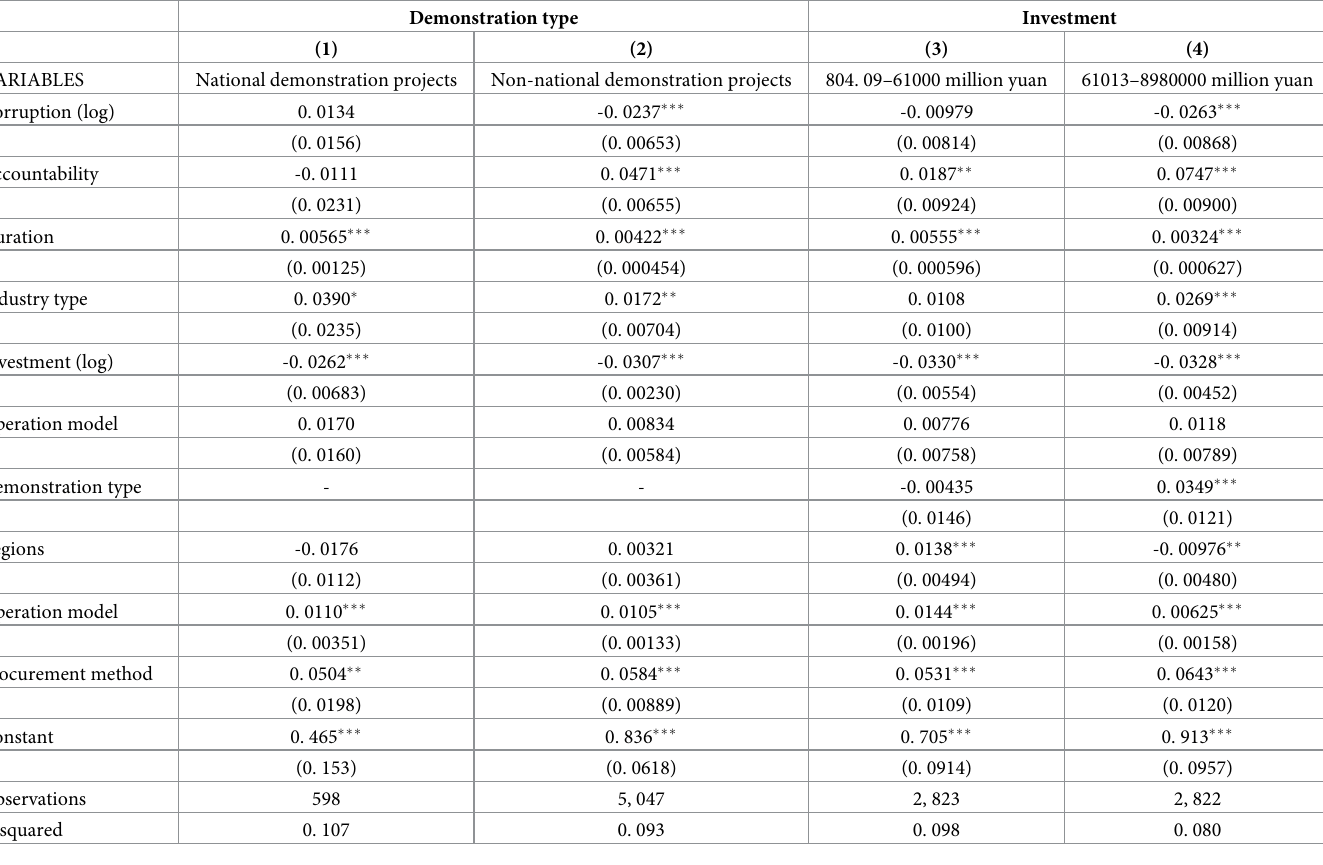
Table 7. Heterogeneity analysis regression